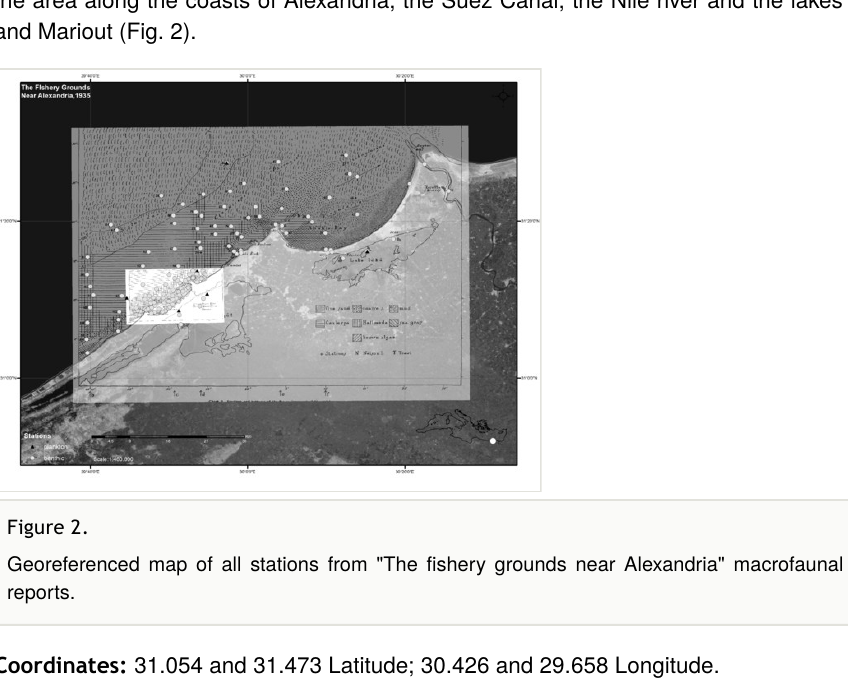
Description: The Egypt expedition covered, with 162 benthic and 10 planktonic stations,